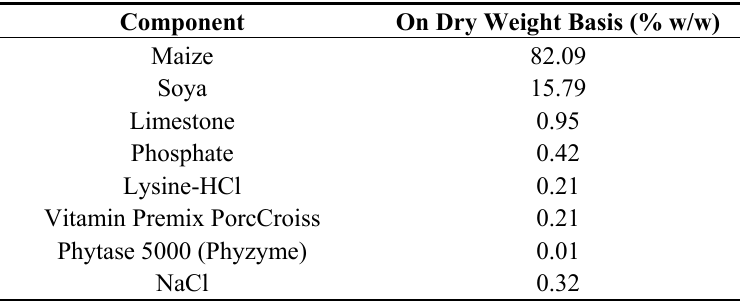
Table 2. Composition of the basic